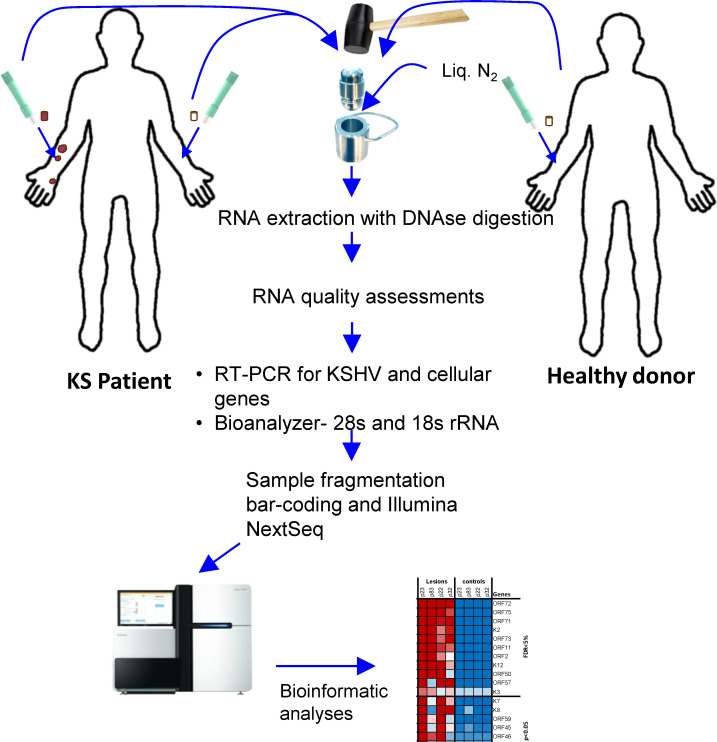
Schematic representation of sample collection, processing, and sequencing.Liq. N2 –Liquid nitrogen.